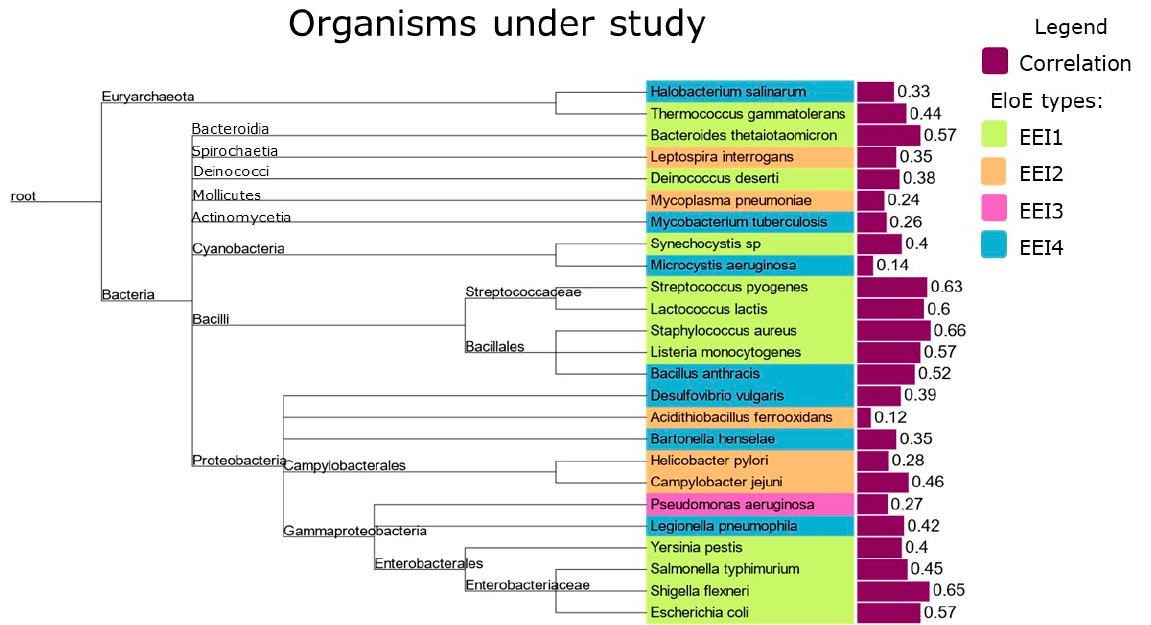
Figure 4. The distribution of the analyzed 25 organisms by taxonomical categories. Arrows point to corresponding higher-order taxa of the analyzed species. A number near a species name corresponds to the base EEI type and a colored square shows a Spearman’s correlation (corr(PA|EEI)) coefficient value (see the legend).